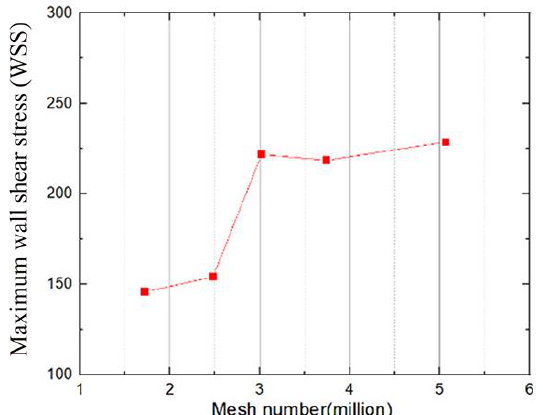
Figure 5. Mesh independence verification.